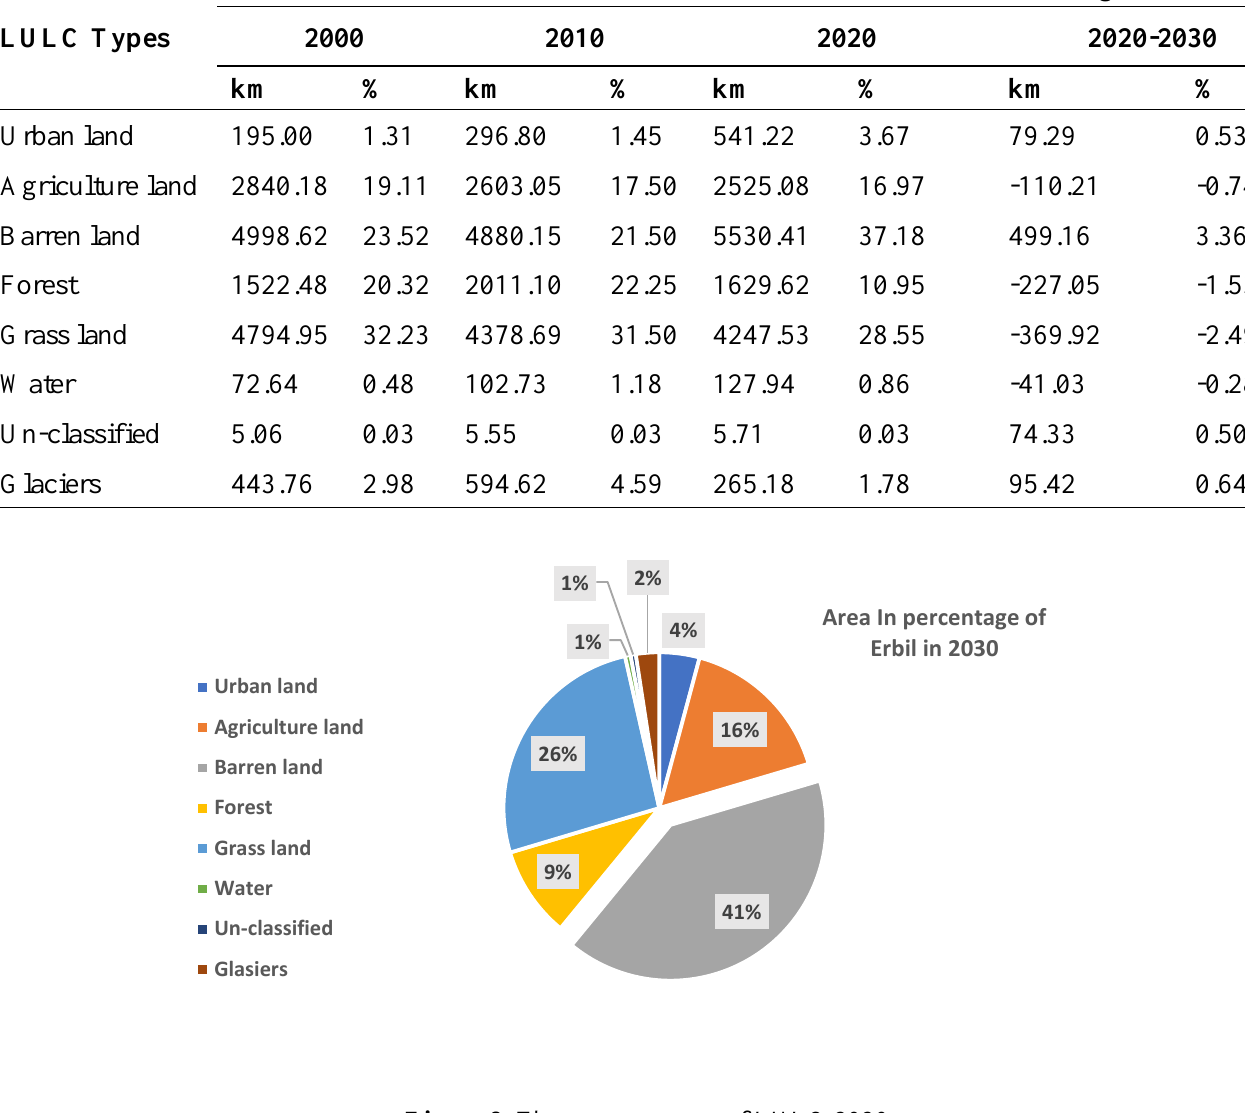
Figure 8. The area coverage of LULC